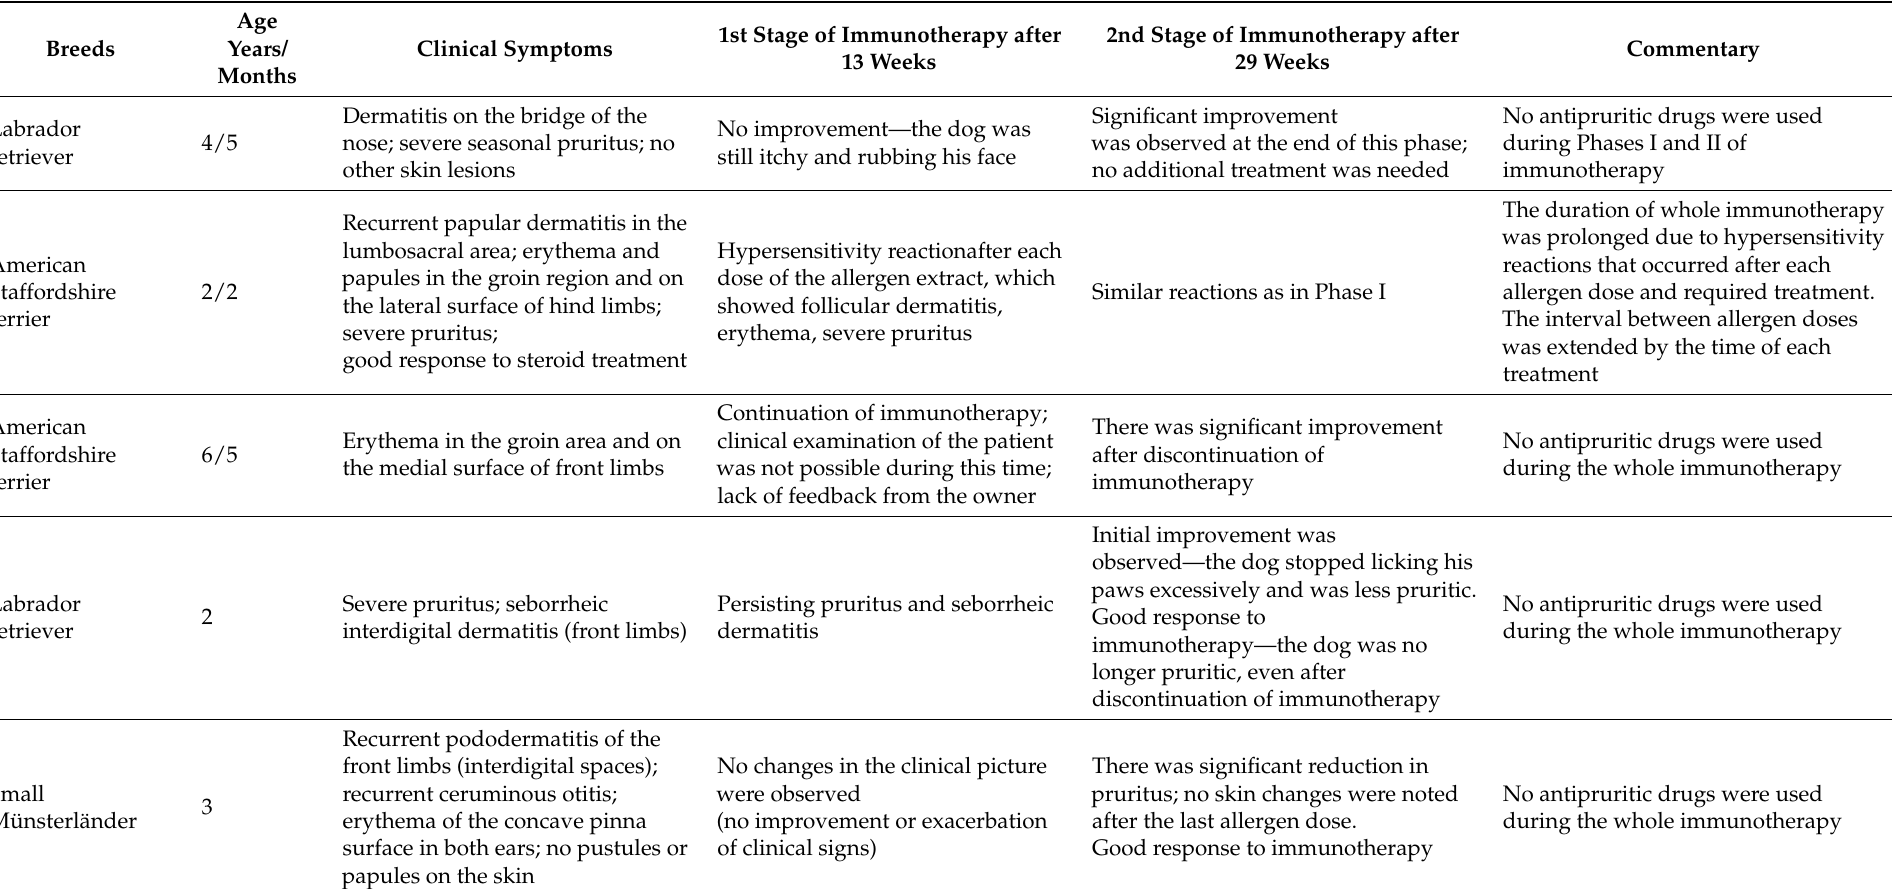
Table 1. Description of patients taking part in experiment: breed, age, clinical symptoms before allergen-specific immunotherapy (ASIT) and reaction to therapy after 13 and 29